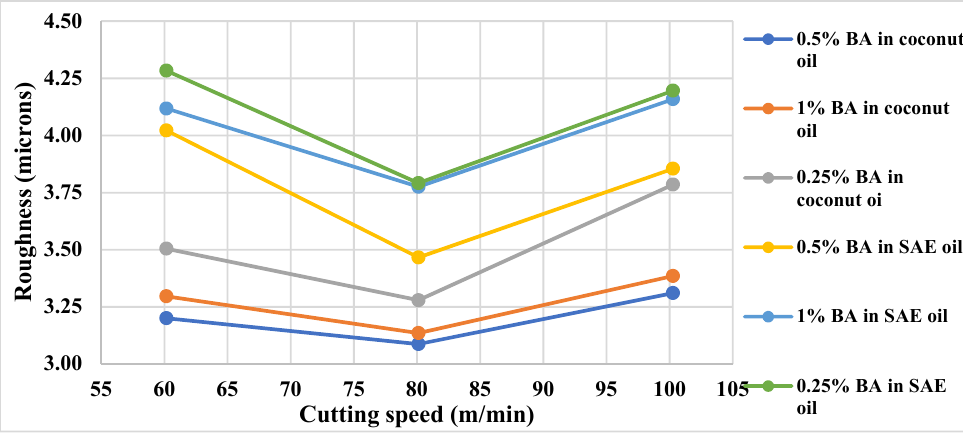
Figure 7. The variation of the surface roughness with the cutting speed [67].